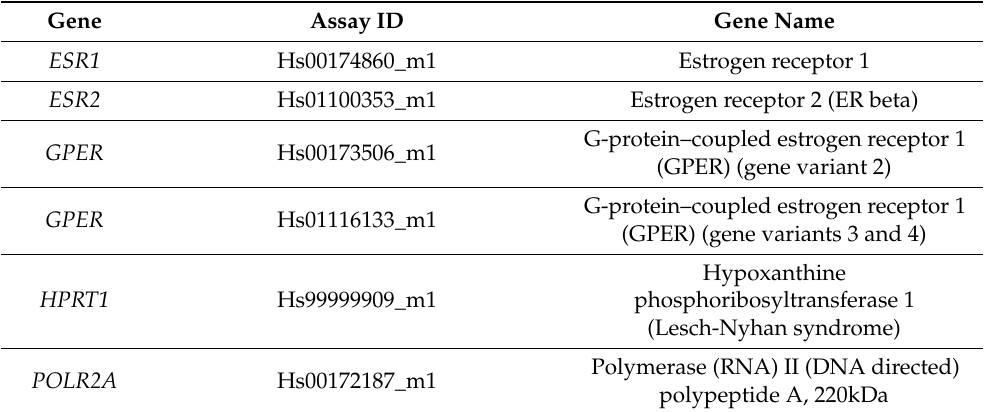
Table 5. Assays for the investigated ESR and GPER genes and reference genes. Gene Assay